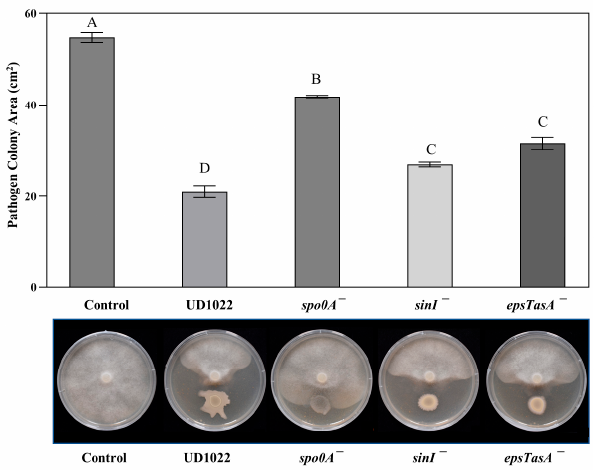
Figure 5. Results of antagonism assays with UD1022 mutants in key biofilm genes against P. medicagi- nis A2A1. Bars are the mean colony area ( n = 3) and standard error of the mean (SE) of the mean from one representative experiment of three experiments performed. The spo0A − treatment antagonism was significantly less than UD1022 ( p < 0.0001), the sinI − treatment was mildly less antagonized than UD1022 ( p = 0.011), and the eps − - tasA − double mutant was less antagonistic than UD1022 ( p =